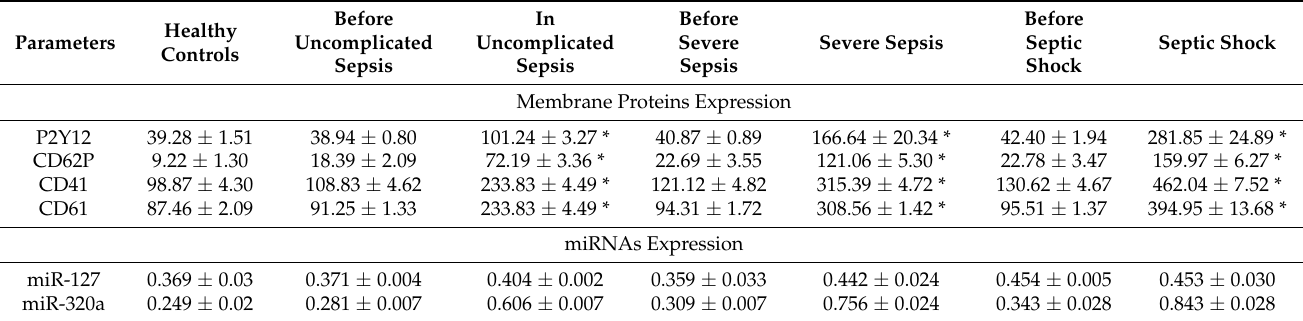
Table 2. Parameters evaluated in platelets of patients and volunteers